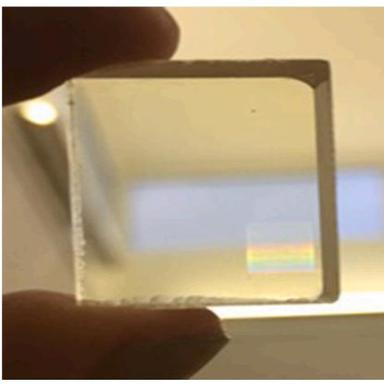
Photo of 5 × 5×7 mm bulky gratings.